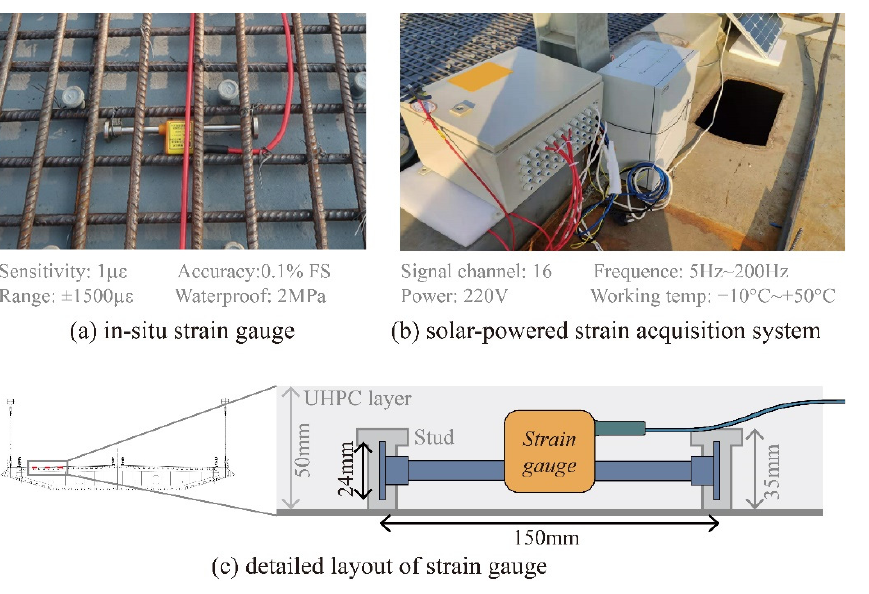
Figure 4. Photo and layout of strain gauge fixed in deck and acquisition system.